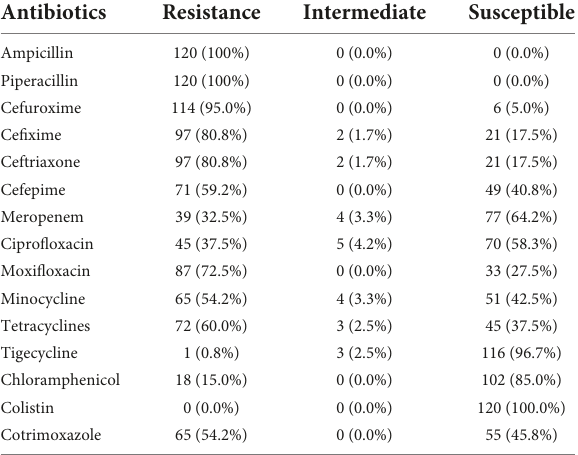
TABLE 2 Antibiotic resistance profile of indigenous K. pneumoniae isolates ( n = 120) against all the antibiotics used in the study. Antibiotics Resistance Intermediate Susceptible